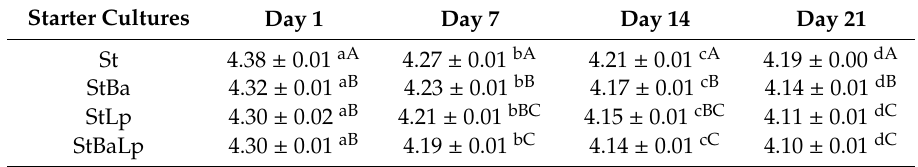
Table 1. Changes in pH in fermented milk from di ff erent starter cultures during 21-day storage at 4 ◦ C.